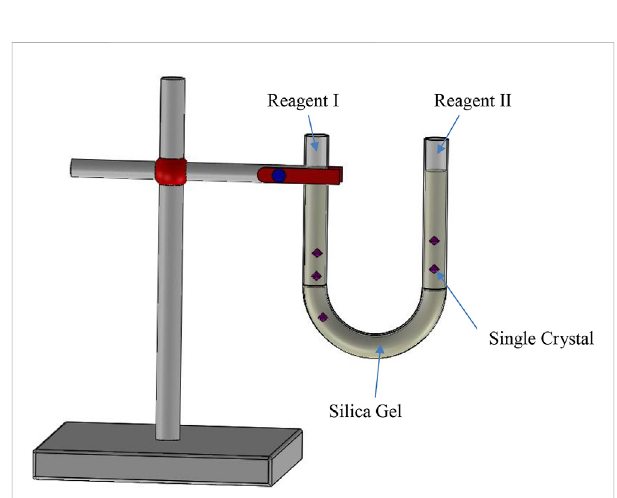
FIGURE 2 Schematic diagram of gel crystal growth U-tube